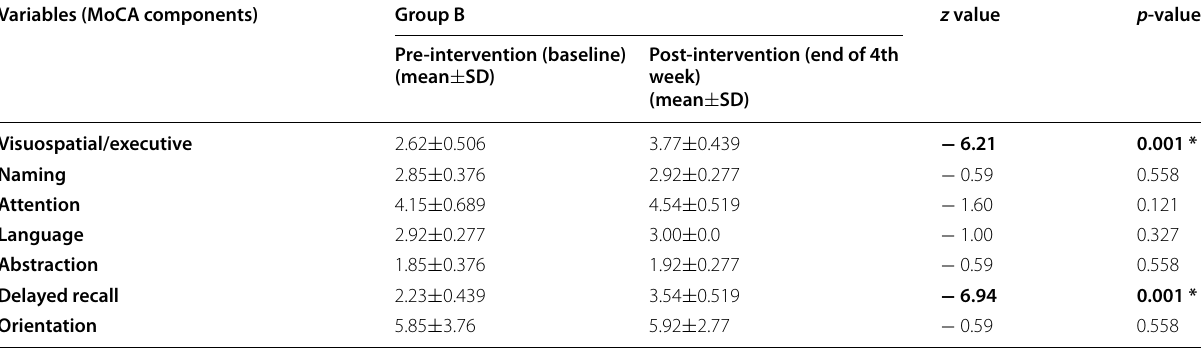
Table 4 Comparison of mean and standard deviation (SD) of various components of the MoCA score at pre- (baseline) and post- intervention (end of 4th week) in group B Variables (MoCA components)